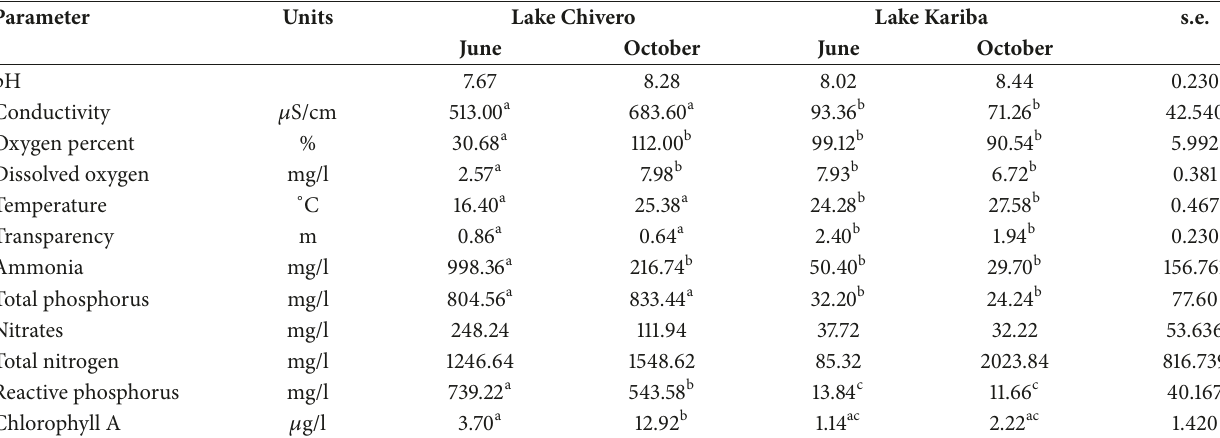
Table 1: Least square means for water physicochemical parameters for Lake Chivero and Lake Kariba in June and October.